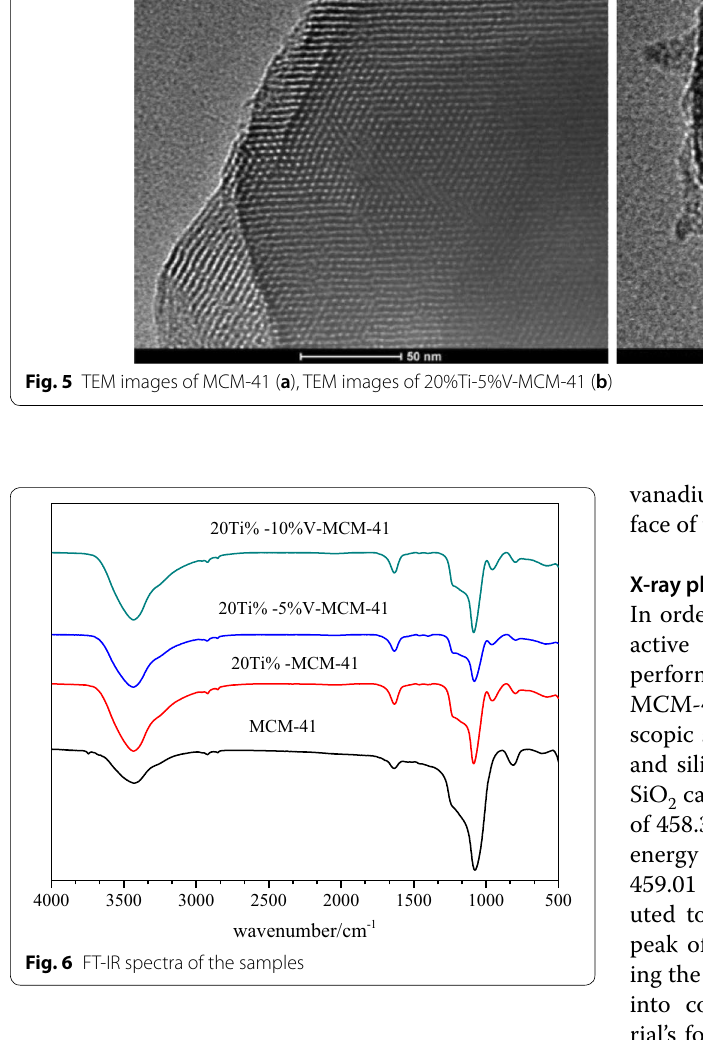
Table 1 Pore structure analysis of samples